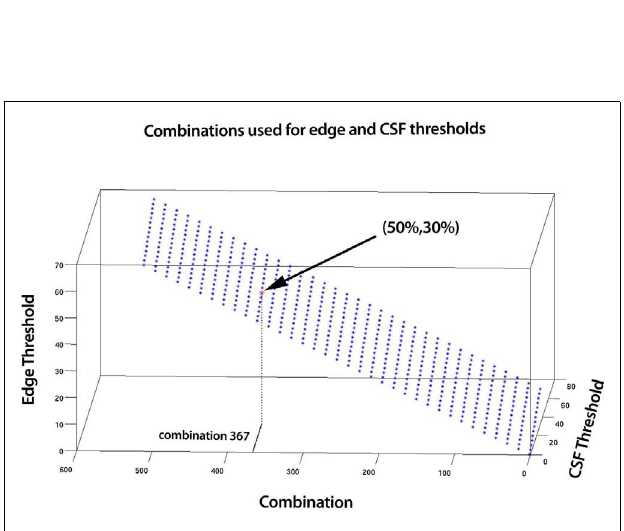
FIGUREA2 |A total of 525 combinations for edge and CSF thresholds ranging from 0 to 70% were tested . Each combination represents an edge and CSF threshold, with combination 0 representing 0% edge and CSF threshold and combination 525 representing 70% edge and CSF threshold. Shown on the graph is combination 367, which corresponds to 50% edge threshold and 30% CSF